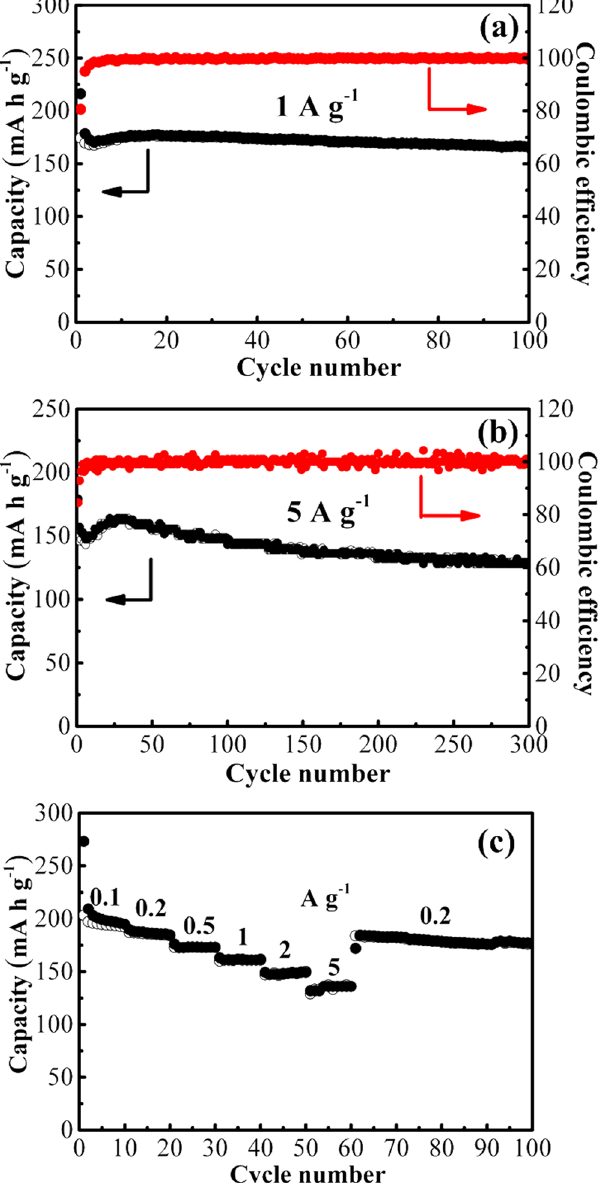
Figure 6. The electrochemical properties of TiO 2 @Nb 2 O 5 composites: cycling performances at different current densities of ( a ) 1 and ( b ) 5 A g − 1 and ( c ) rate capability from 0.1 to 5 A g − 1